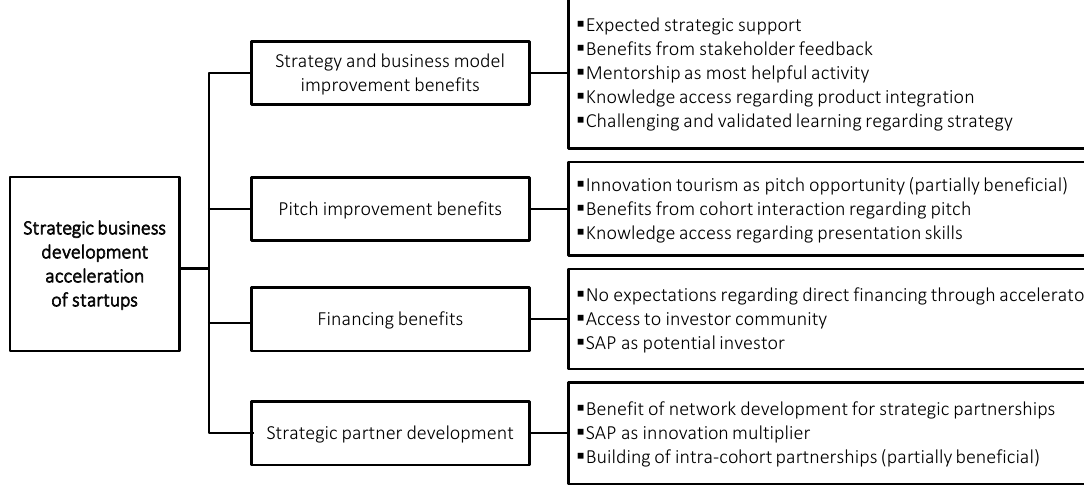
Figure 4. Strategic business development acceleration of